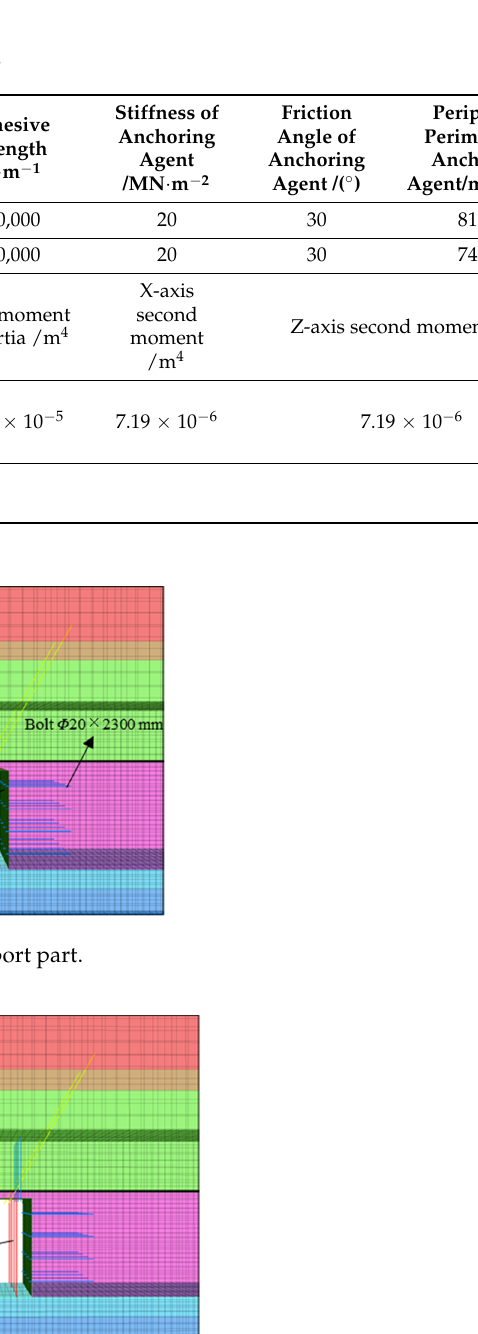
Table 4. Supporting material parameters.